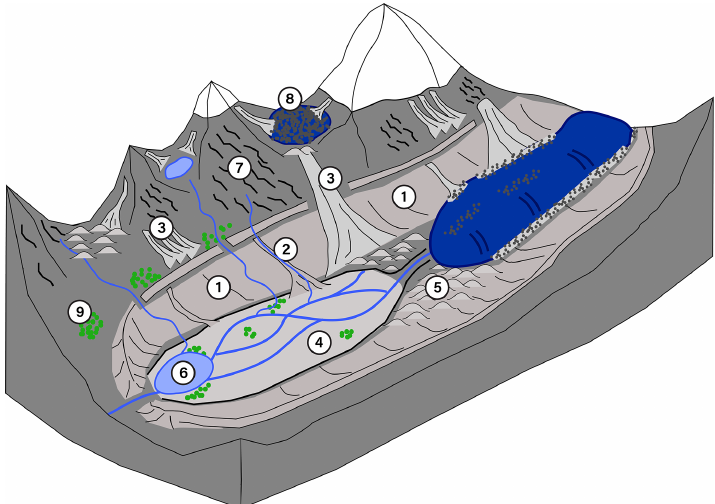
Figure 1. General overview of geomorphological landforms typical of proglacial zones. (1) Lateral moraine (grey); (2) debris cone; (3) talus slope (light grey); (4) fluvial outwash plain; (5) glacial deposit (till); (6) proglacial lake; (7) apparent bedrock (dark grey); (8) debris-covered rock glacier; (9) vegetation patches. Snow on the mountain tops is in white, and the glacier is in blue on the right (figure inspired by Temme,